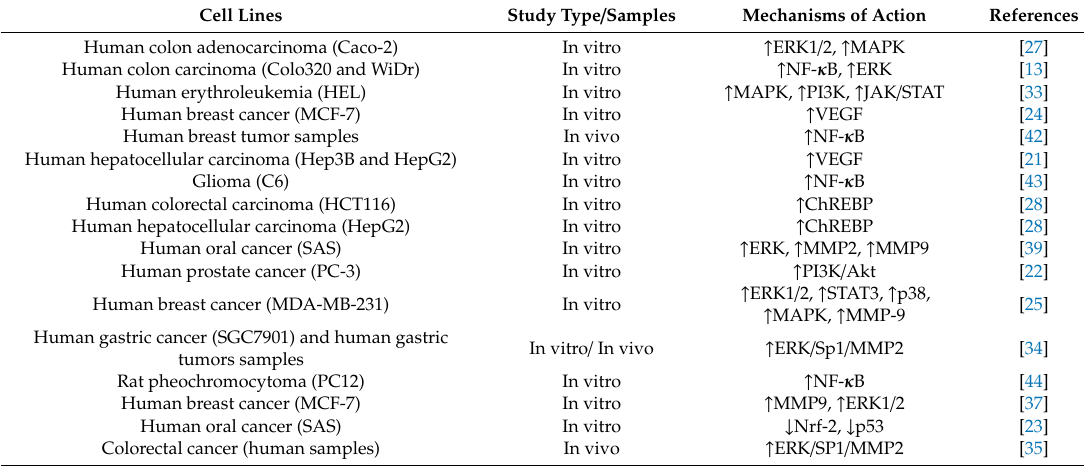
Table 1. Role of the advanced glycation end products (AGEs)-receptor for advanced glycation end product (RAGE) axis in cancer